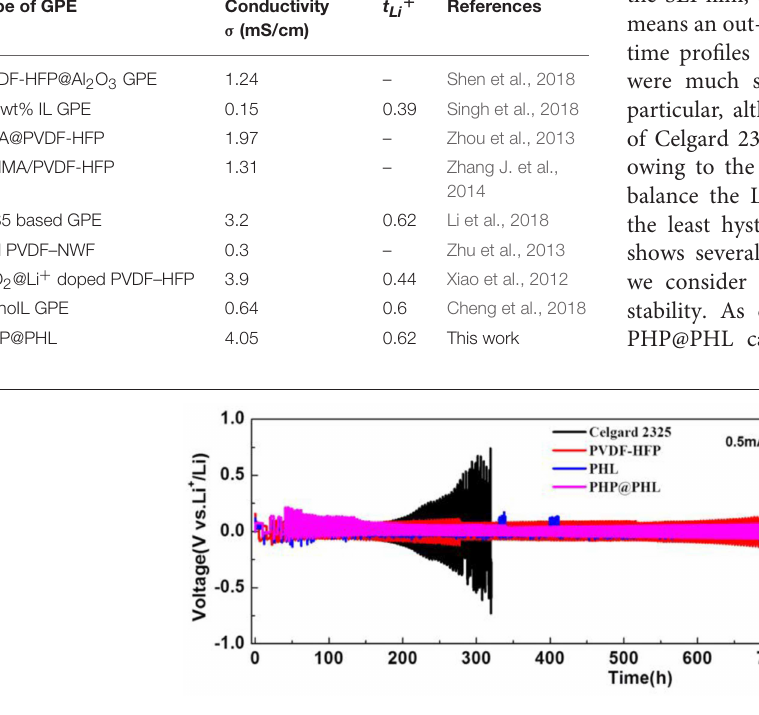
Frontiers in Chemistry |